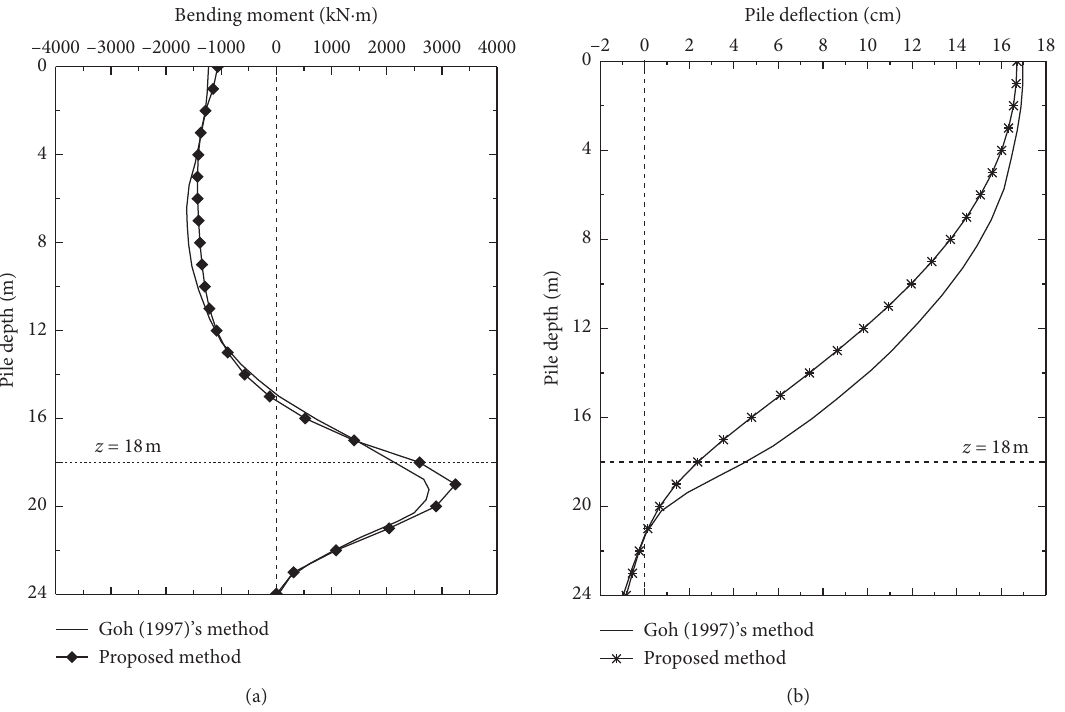
Figure 6: Comparison of bending moment and pile deflection. (a) Bending moment. (b) Pile